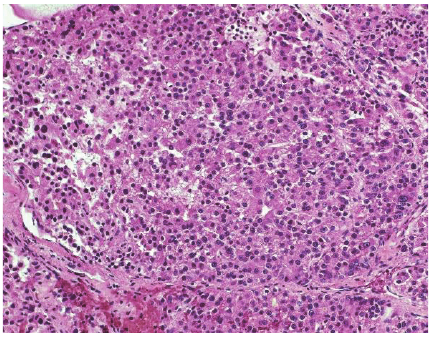
Figure 6: High magnification field shows thick trabecula com- pressed into compact mass surrounded by